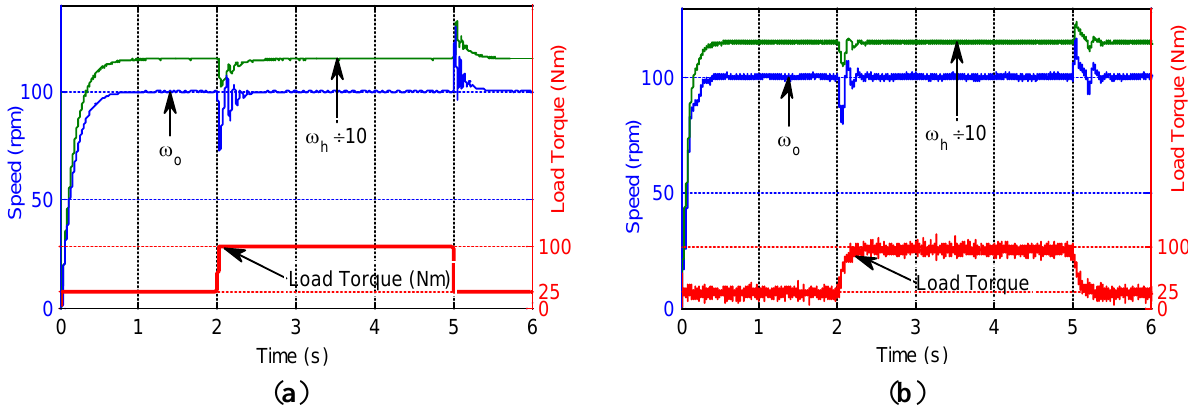
Figure 15. PDD responses under IP. ( a ) Simulated; ( b )